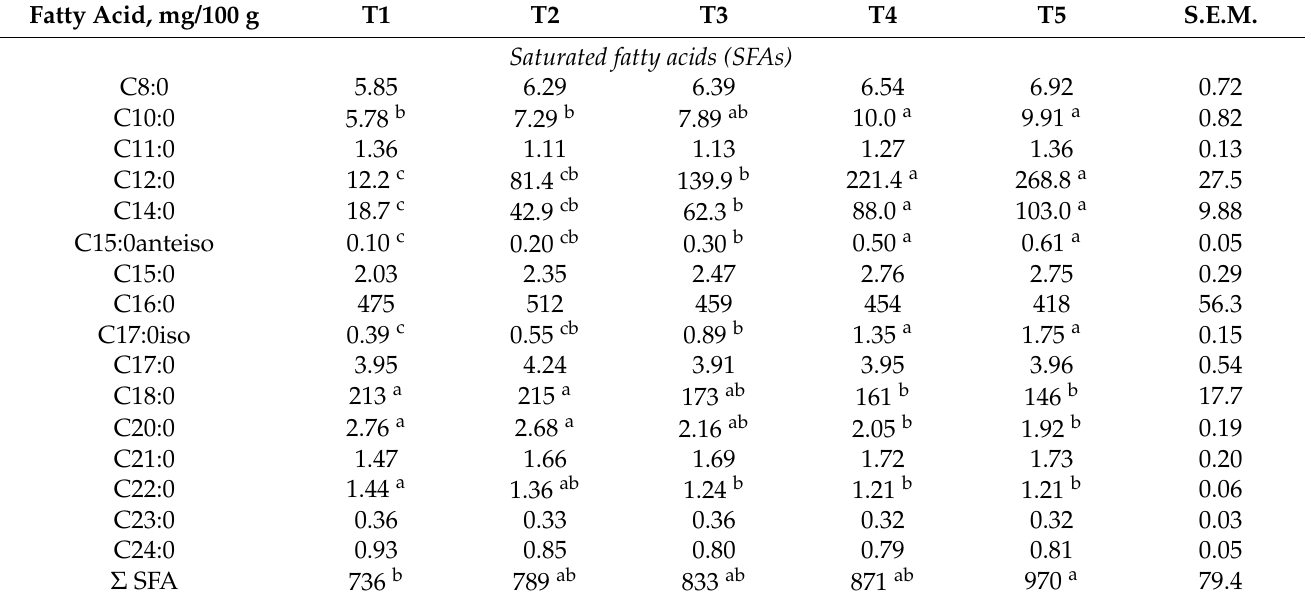
Table 7. Predicted least square means of fatty acids composition of breast muscle obtained from broiler chickens at 42 days of age fed different levels of Black Soldier Fly larvae